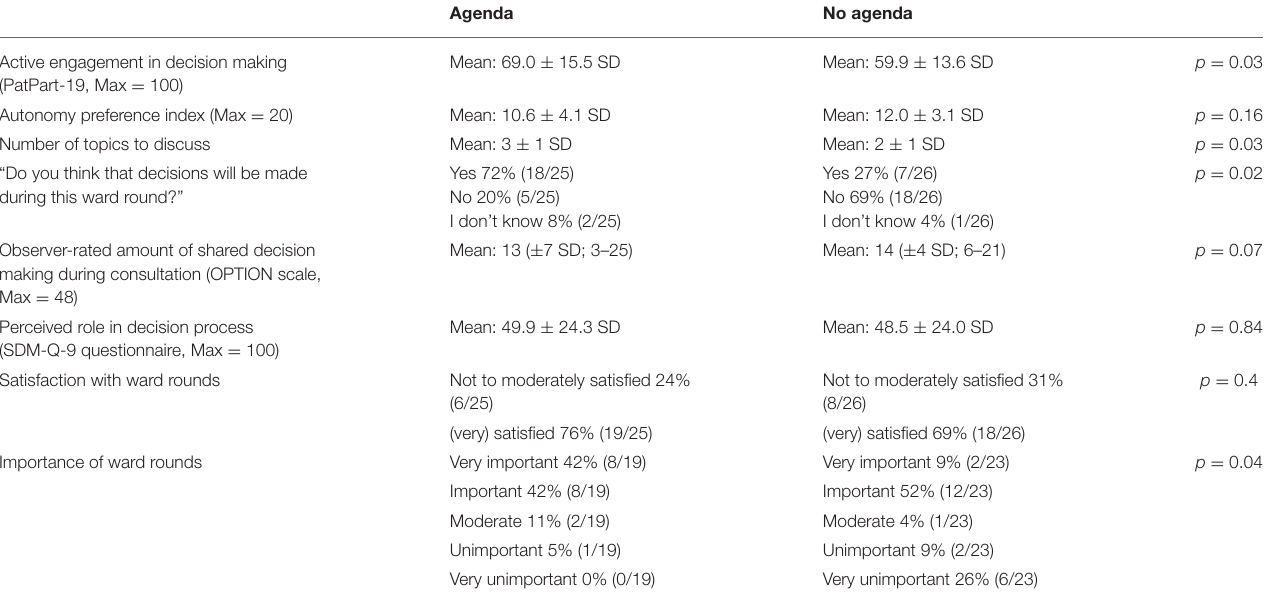
TABLE 2 | Main results concerning patient participation.